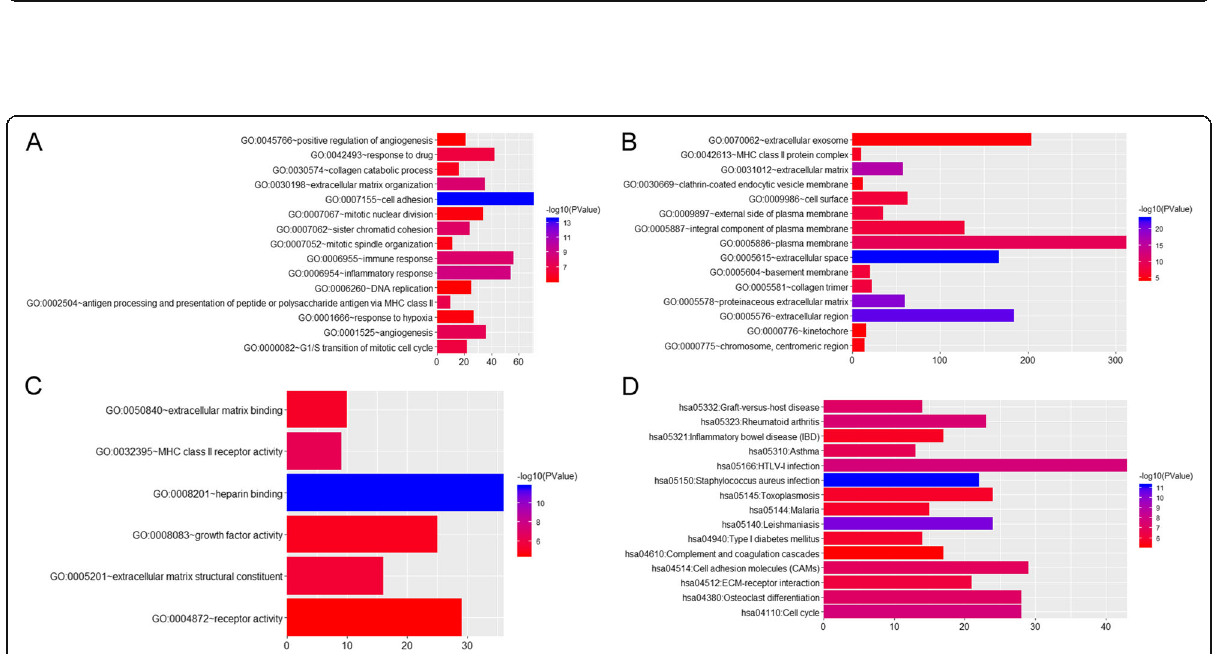
Fig. 2 The heatmap of DEmiRNAs between OA and normal controls. Row and column represented DEmiRNAs and tissue samples, respectively. The color scale represented the expression levels. The red and green color represented the up- and down-regulated